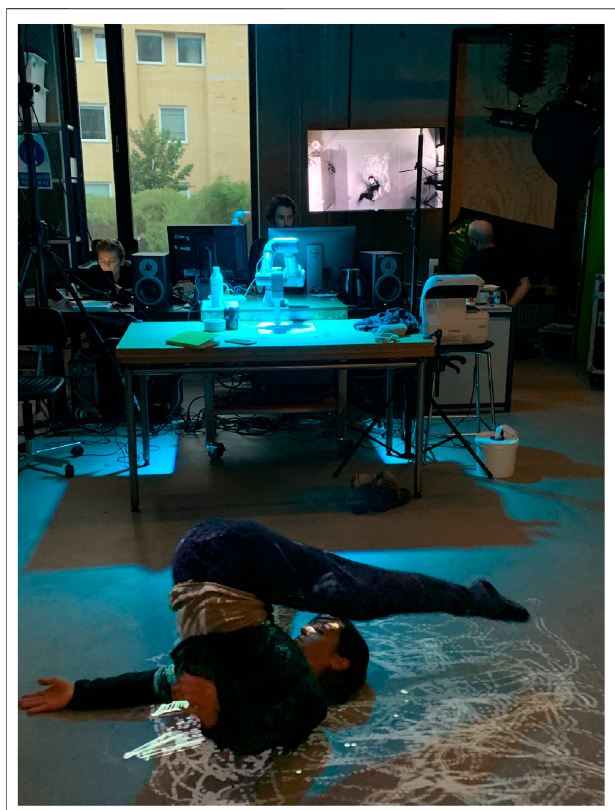
FIGURE 8 | The research team iterating the design for the projection animations and performer tracking during a workshop at the RELATE lab. On the screen is projected a real-time feed of the performer and animations captured from a video camera mounted